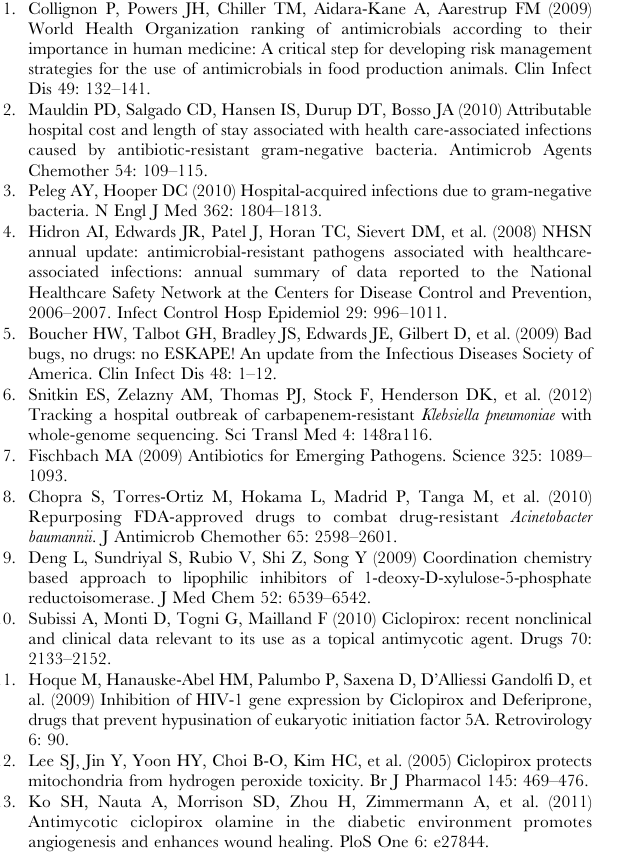
(TIF) Figure S3 Ciclopirox effects on P. aeruginosa growth. Mid-logarithmic cultures (O.D. = 0.4) of ATCC H 27853 TM P. aeruginosa cultures were spread onto LB agar without (left) or with 9 m g/ml ciclopirox (middle) and grown at 37 u C. After 24 hours, plates were imaged. (TIF) Table S1 Antibiotic susceptibility status for fluoroquin- olone-resistant clinical isolates. Table S2 Patient demographics and clinical isolate culture sites. Table S3 Antibiotics MICs in galactose pathway dele- tion